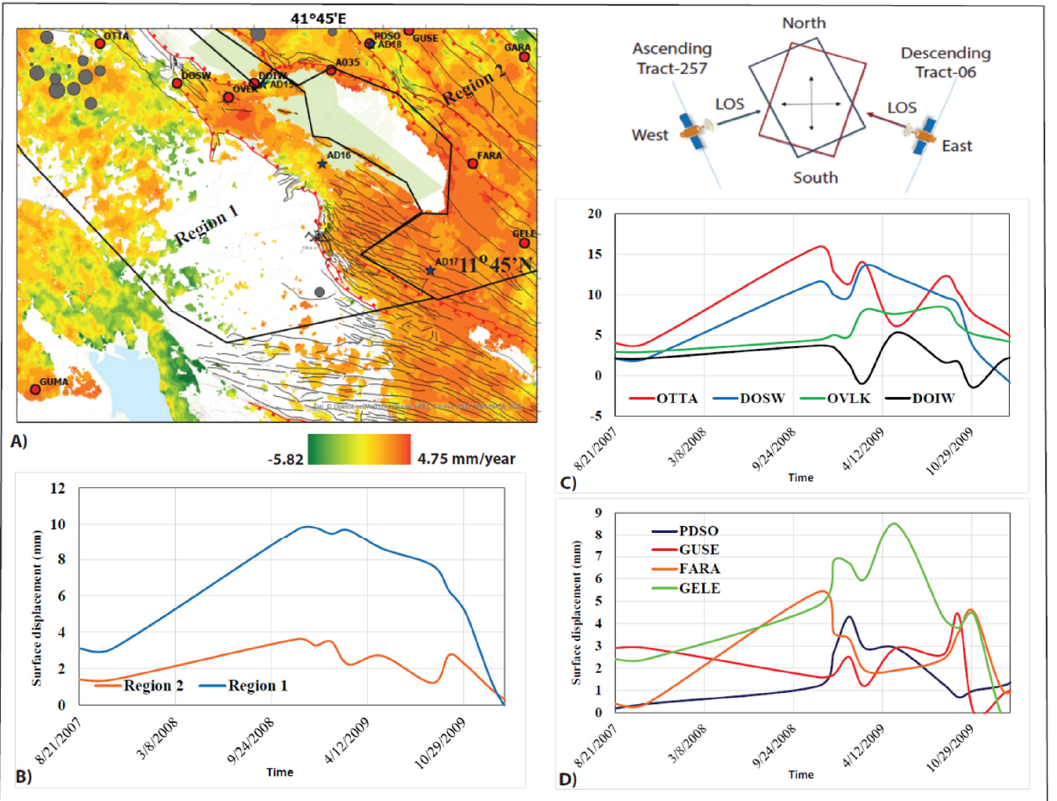
Figure 8. ( A ) The mean velocity at the LOS of the satellite for the descending tract 006. Surface deformation referenced in the scale bar denotes ~0 mm/year as a yellowish color, anything to the right is measured as positive mean values and the negative mean values are to the left spanning to the green color; ( B ) The multidimensional time profiling of the surface displacement in mm for the descending tract 006 that is referenced temporally to the master scene (10 October 2007): the blue line represents the average of all the pixels confined in Region 1 and the orange line represents the average displacement in mm derived from all the pixels found in Region 2; ( C ) The multidimensional time profiling of the surface displacement (mm) for all the pixels that consist of the GPS sites in Region 1; ( D ) The multidimensional time profiling of the surface displacement for all the pixels that consist of the GPS sites in Region 2. See Supplement S4.